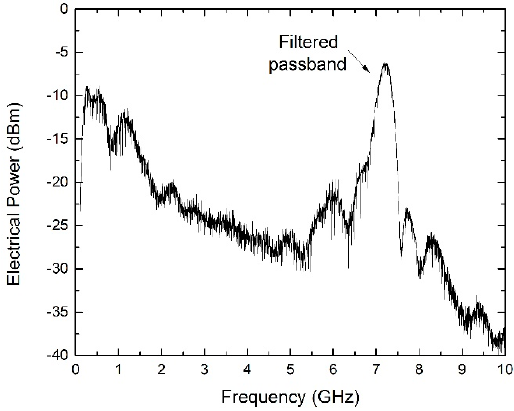
Figure 8. Radio frequency (RF) spectrum measured at the output of the lower arm.